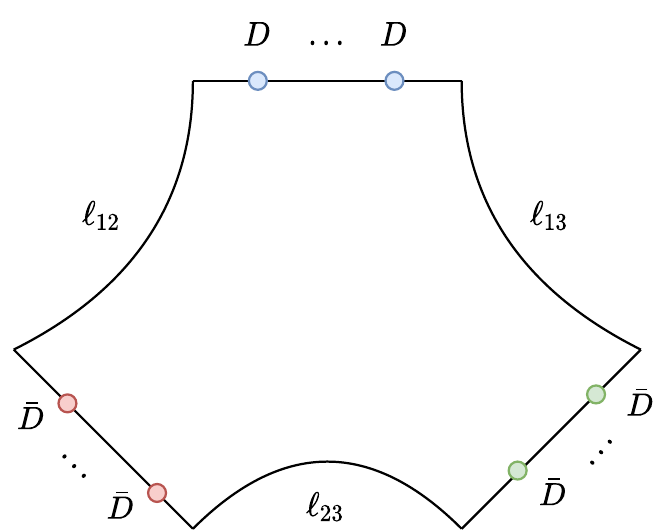
Figure 10 . The first operator is orthogonal to the other two operators, once we perform crossing we end up with identical excitations in the physical edge, which scatter trivially. This configuration corresponds to the abelian configuration A . By considering the other configurations where the 1 operators two and three are the ones orthogonal to the other operators we get the abelian structures A and A , 2 3